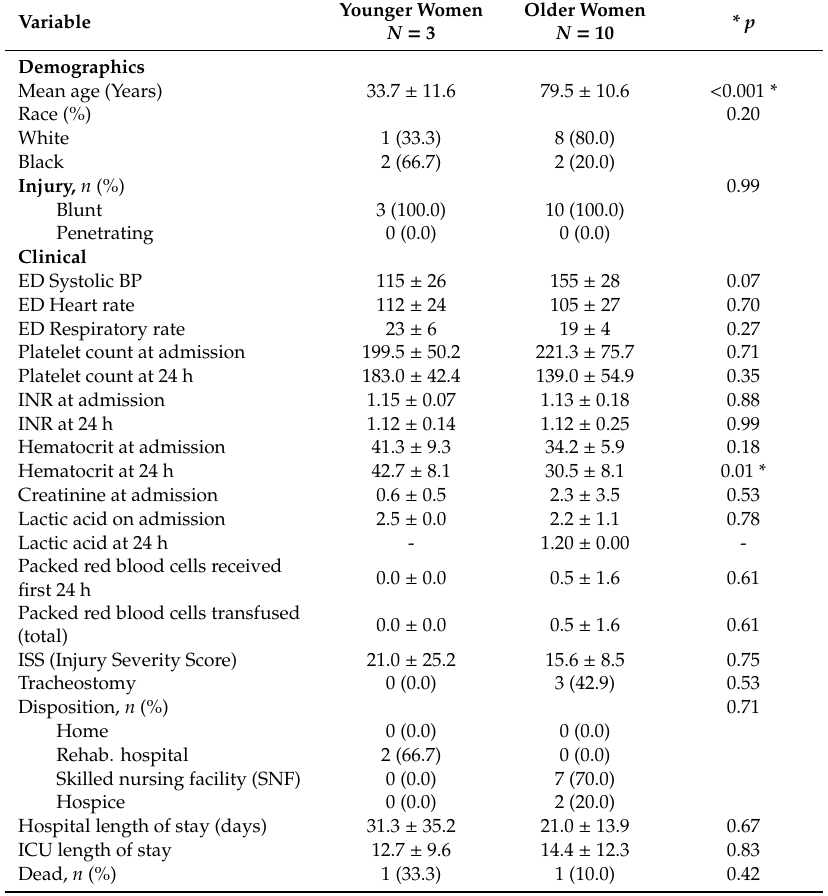
Demographic, injury, and clinical characteristics of female trauma patients with ventilator-associated pneumonia